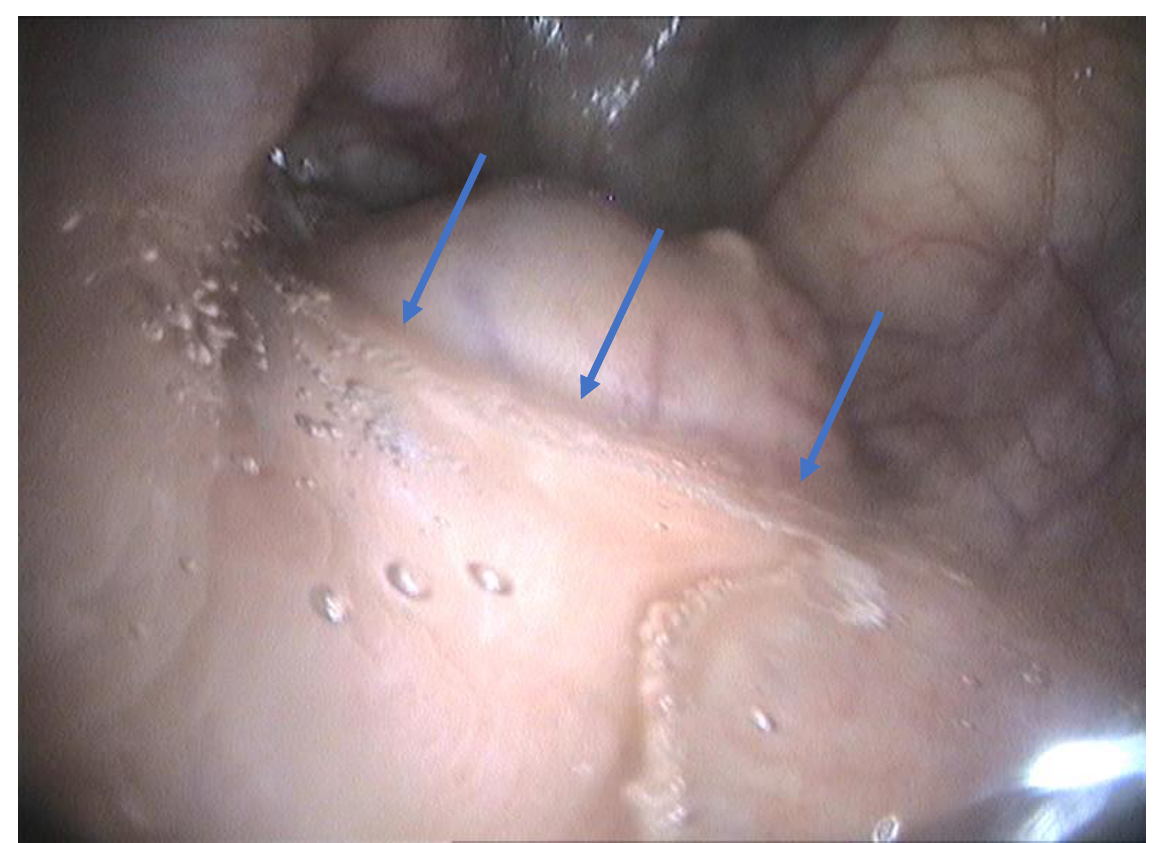
Figure 3: Endoscopic appearance of the partially solidified poloxamer gel 4 minutes 25 seconds after infusion into the guttural pouch of a strangles carrier. Lifiting of the head did not change the appearance of the meniscus within the pouch demonstrating it was already partially set. Arrows show meniscus of solidified gel against retropharyngeal mass (lymph